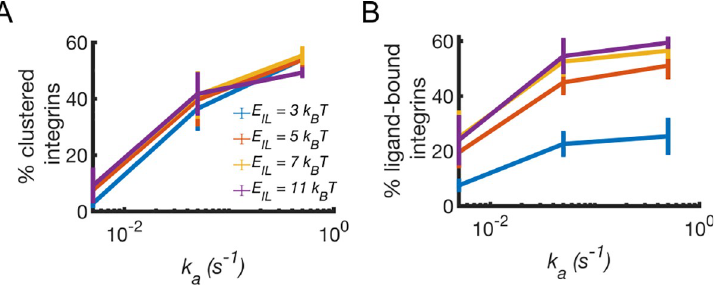
Fig 4. Integrin activation rate enhances clustering and ligand binding. (A) Average percentage of clustered integrins as a function of activation rate, k a , by varying ligand binding affinity, E IL , and keeping E II = 5 k B T. (B) Corresponding average percentage of ligand-bound integrins. Data are computed between 10–200 s of simulations from three independent runs. Error bars indicate standard deviation from the